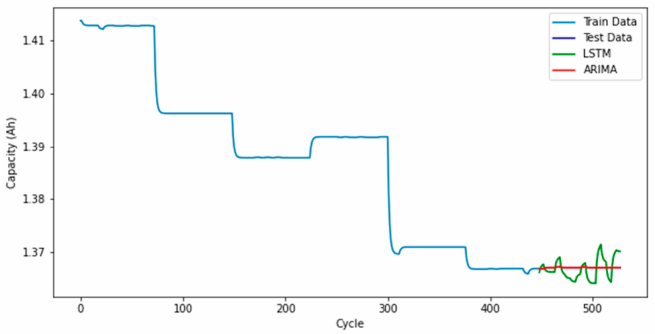
Figure 13. Train, test, and predicted data results from ARIMA and LSTM models for